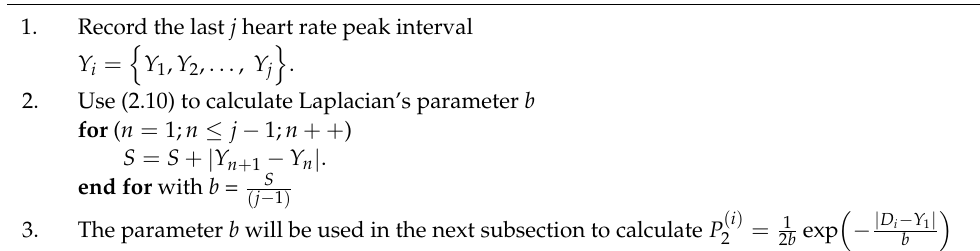
Algorithm 2. Laplacian distribution procedure.